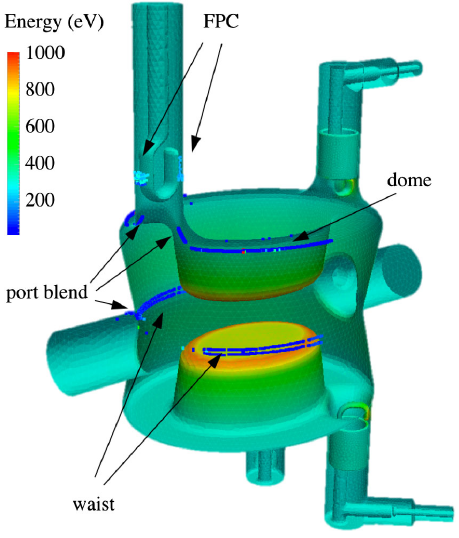
FIG. 4. Multipacting sites found in a DQW cavity by ACE 3 P Track3P. The color scale represents the impact energy in eV of multipacting